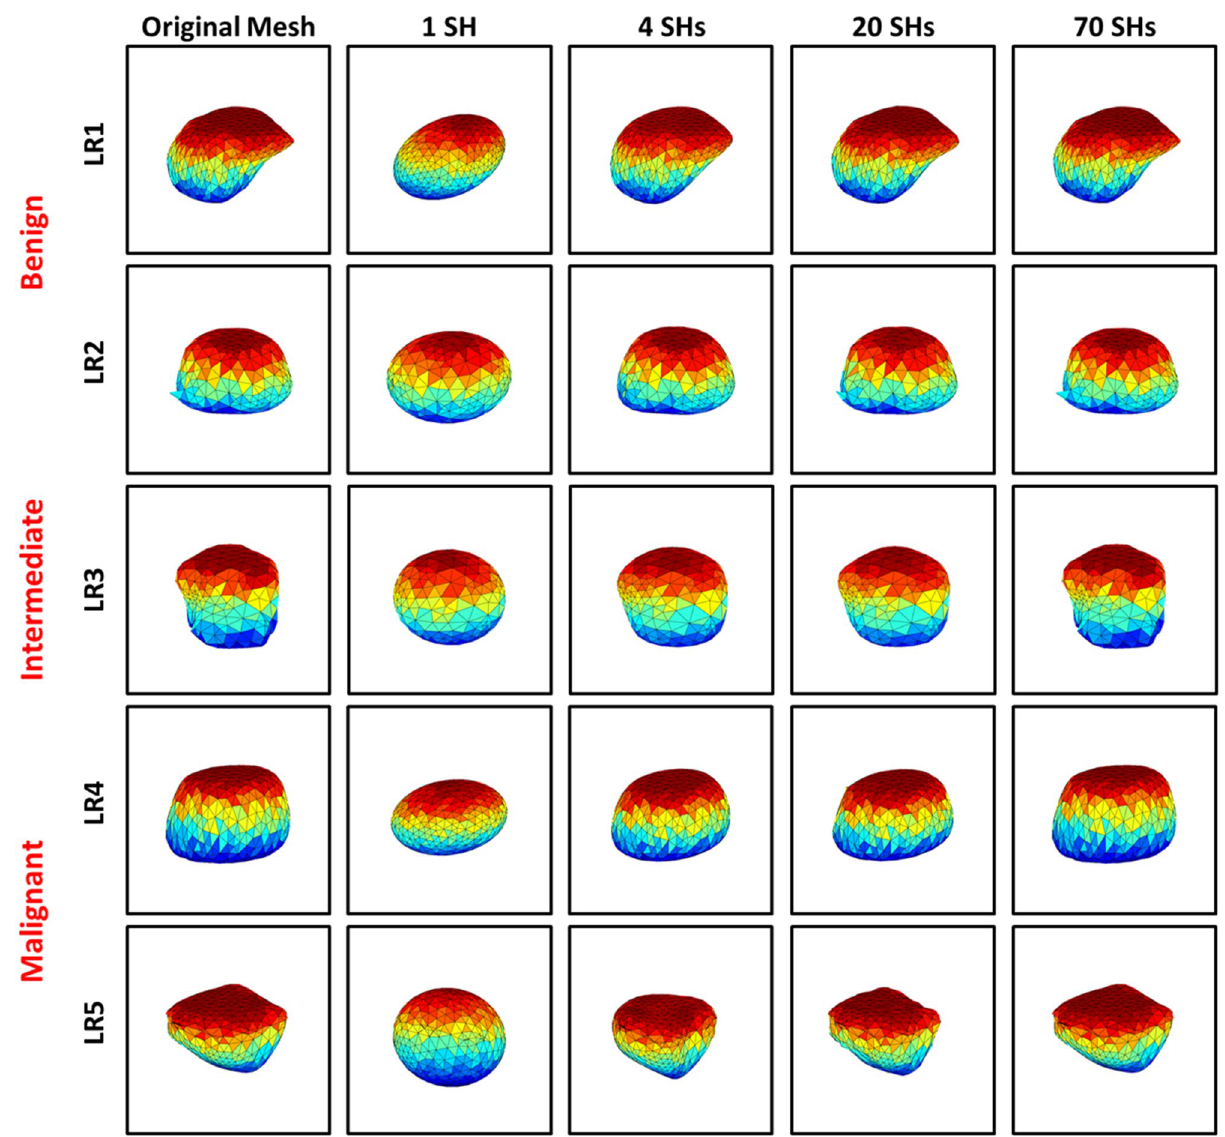
Figure 4. Morphology approximation of two benign (LR1-2), intermediate (LR3), and two malignant (LR4-5)